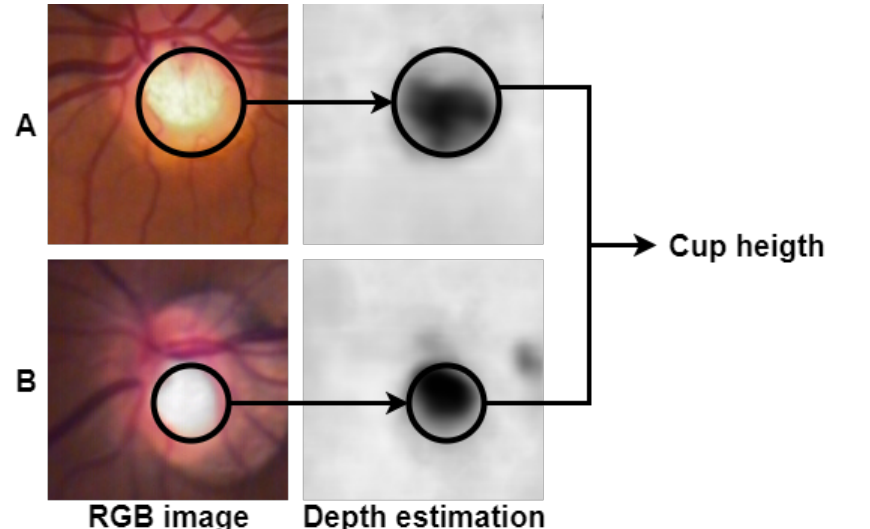
Figure 5. Example of depth estimation of two optic discs. ( A ). Optic disc with glaucoma, ( B ). Optic disc without glaucoma.